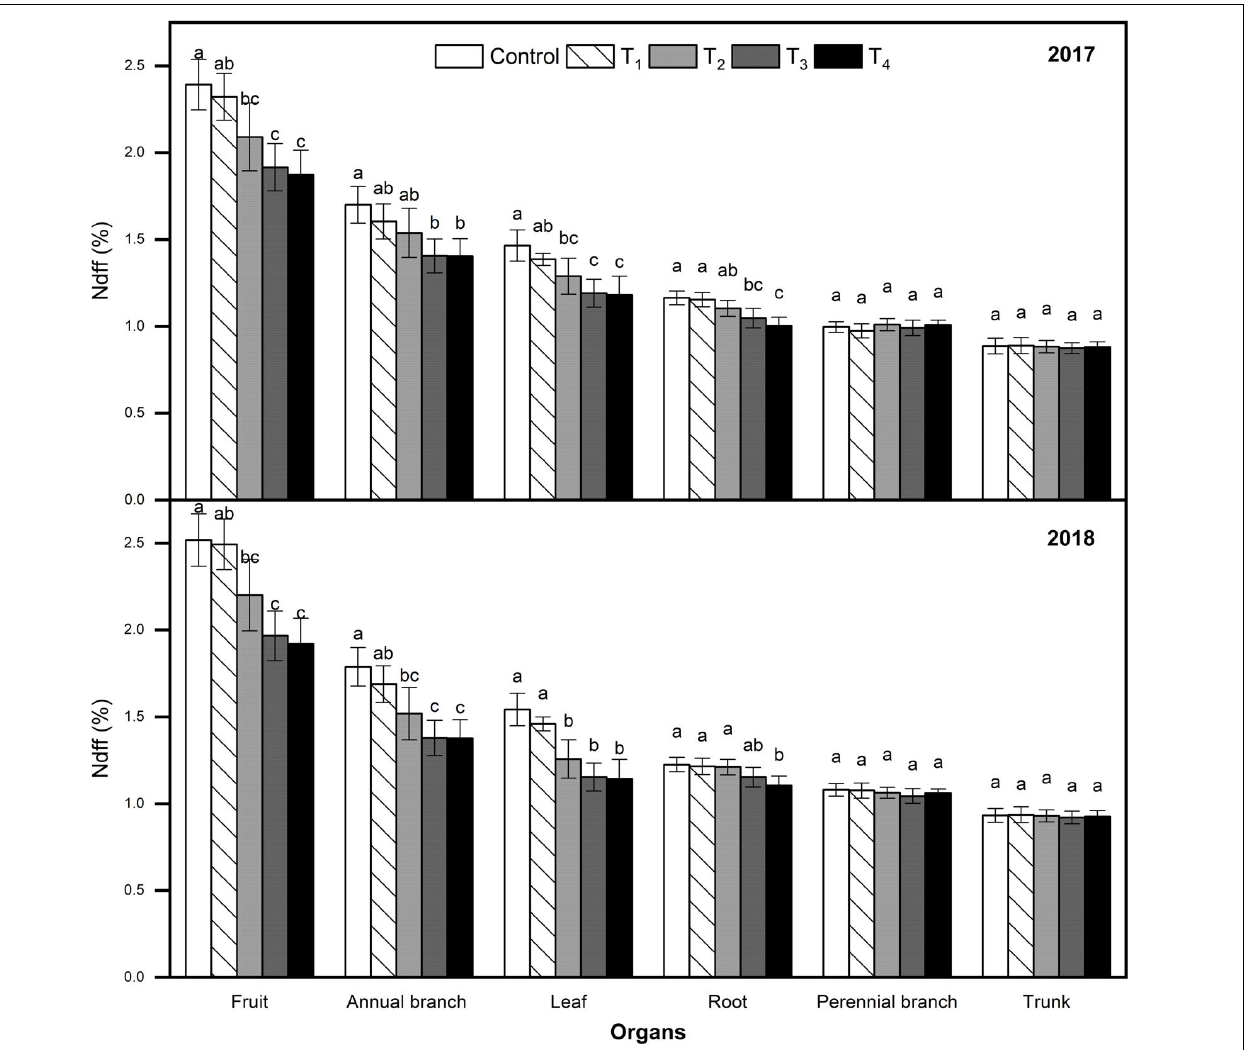
Frontiers in Plant Science |